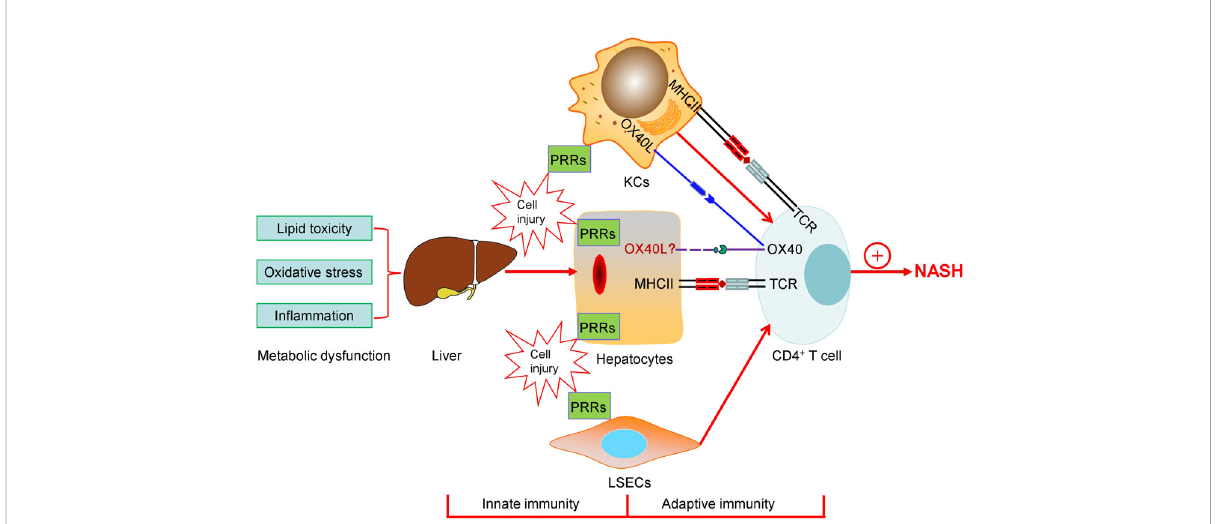
FIGURE 1 The schematic diagram of both innate immunity and adaptive immunity contributing to the progression of NASH. Lipid toxicity, oxidative stress, and in fl ammation may give rise to the injuries of hepatocytes, macrophages (KCs), and liver sinusoidal endothelial cells (LSECs), where PRRs including TLRs and NLPR3 in fl ammasome sense the signals through both pathogen- and danger-associated molecular patterns and trigger proin fl ammatory responses. KCs act as a bridge between the innate and the adaptive immune responses. The roles of LSECs in NASH are not discussed in the present paper. Hepatocytes as APCs may play a role in T cell-mediated adaptive immunity and express the MHCII molecules, which are elevated during NASH, providing the fi rst signal for CD4 + T cell activation. Simultaneously, T cell costimulatory signal pathways, such as OX40-OX40L, which may mediate the cross-talk between hepatocytes and T-cells, are associated with the progression of NASH. Finally, CD4 + T cells are involved in the pathogenesis and development of